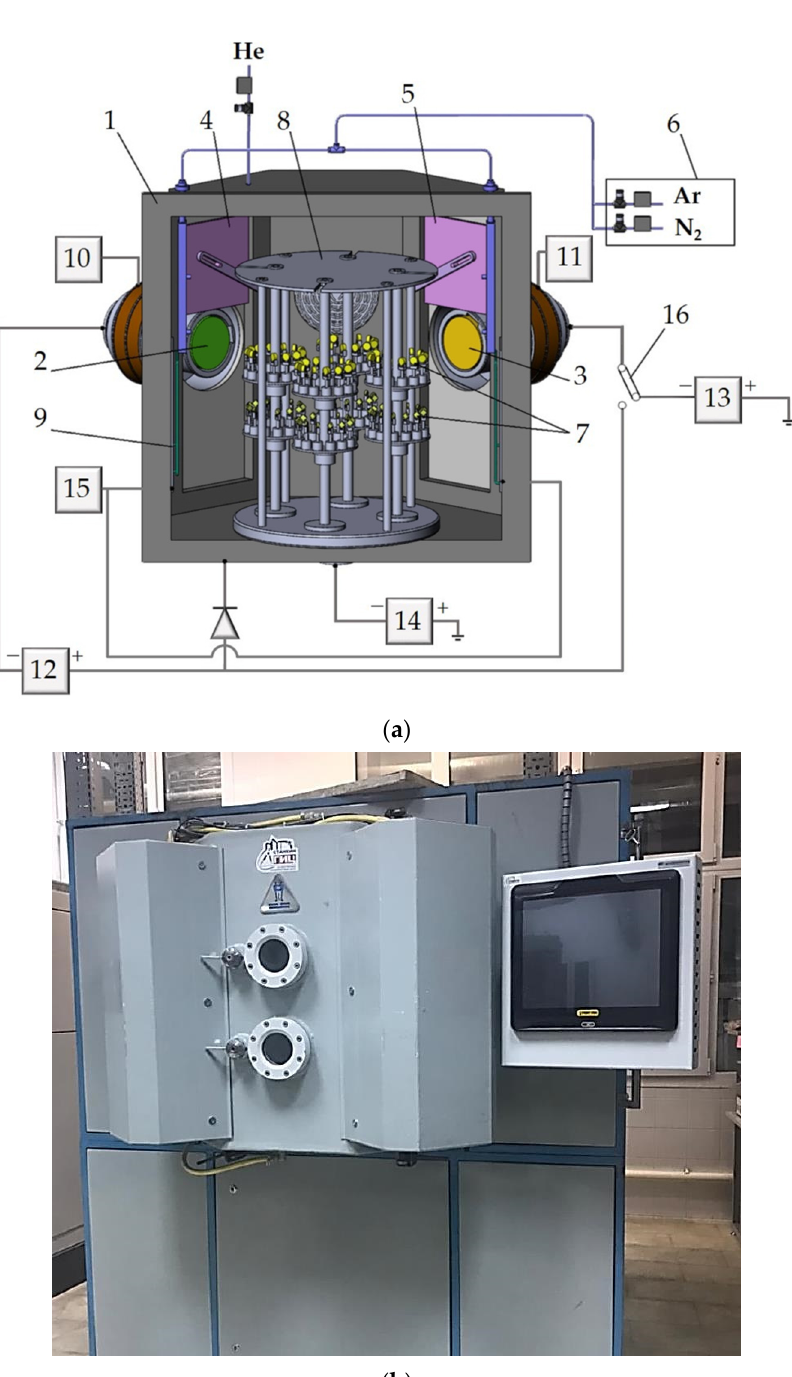
Figure 3. ( a ) Schematic diagram of a technological unit for coating ceramic inserts: 1—vacuum chamber; 2, 3—cathodes; 4, 5—cathode shutters; 6—gas supply system; 7—ceramic inserts; 8—planetary rotation device; 9—heating element; 10, 11—power sources of cathode coils; 12, 13—cathode current sources; 14—reference voltage source; 15—heating element power source; 16—switch; ( b ) installation